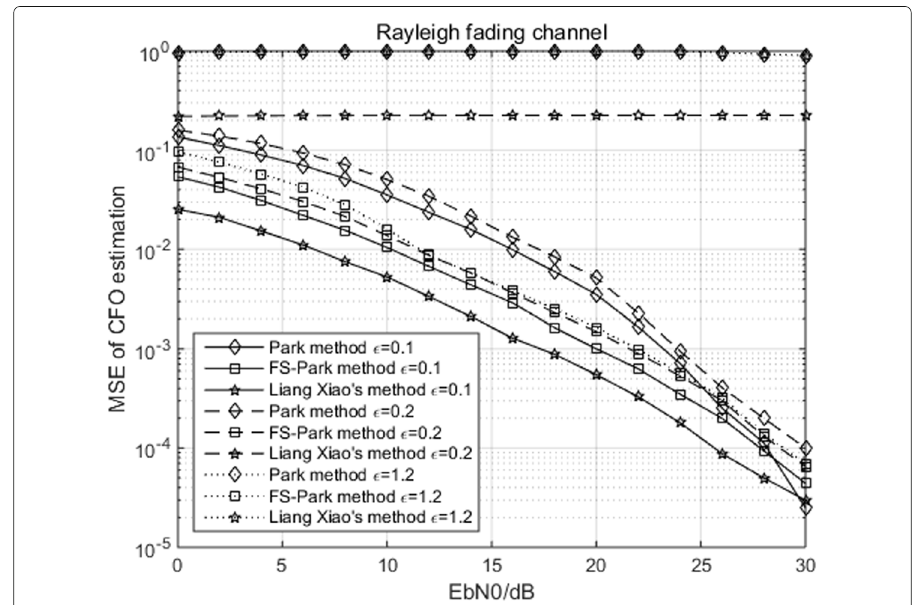
Fig. 11 MSE performance of various estimators with different